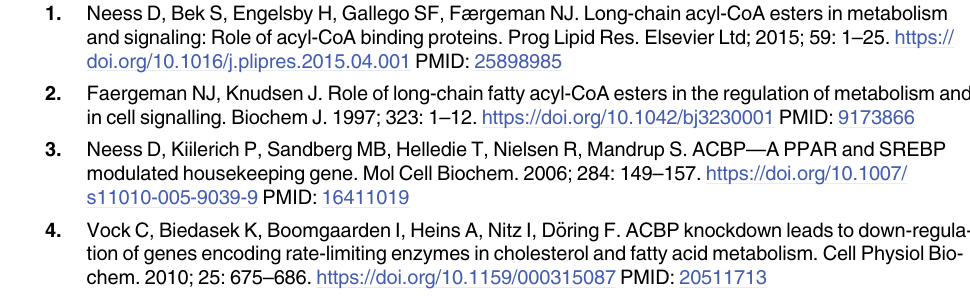
S1 Table. Primer sequences used for qPCR amplification. List of all primer sequences that were used for gene expression determinations by qPCR. S2 Table. Additional information on the primers. Detailed information on properties of primers that were used in qPCR experiments. S3 Table. Primer sequences used for dsRNA synthesis. List of primer sequences that were used for the synthesis of dsRNA, used in knockdown